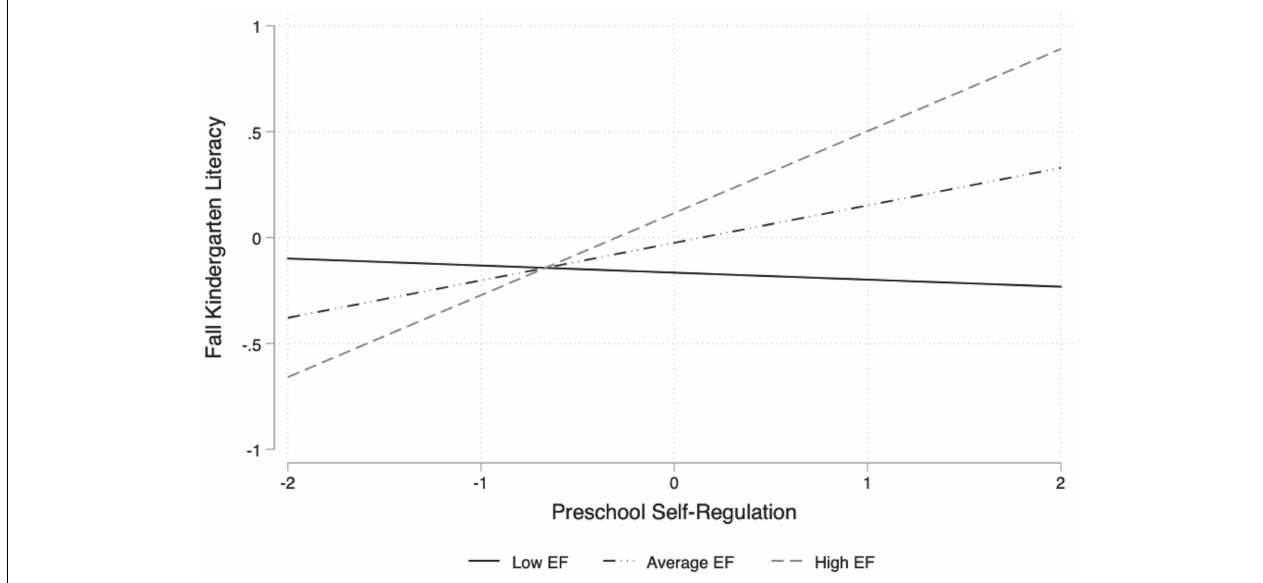
FIGURE 2 | Interaction between teacher-rated self-regulation and direct assessment of executive function for children’s fall of kindergarten literacy skills. Note. EF = Executive Function; Executive Function and Self-Regulation are mean-centered and standardized; Low EF = 1 SD below the mean, Average EF = mean, High EF = 1 SD above the